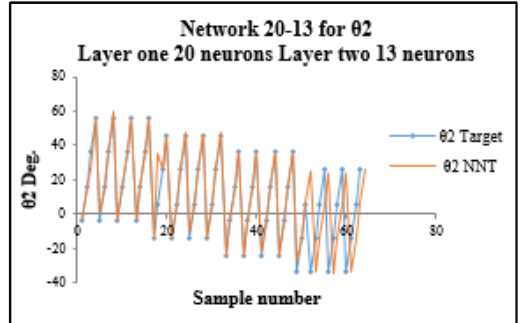
Fig. 22. θ 2 target Vs. θ 2 neural network two